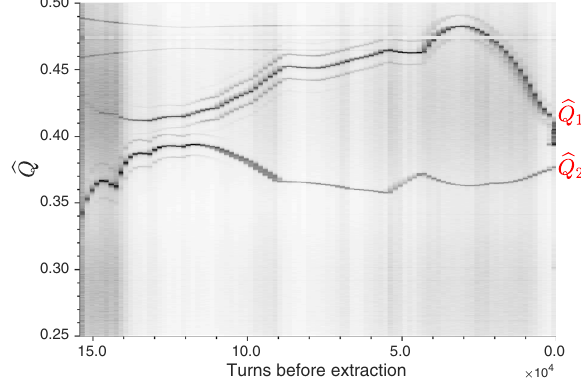
FIG. 13. Tune measurement along booster ramp with emittance exchange. The horizontal tune is brought close to the vertical one during the last ≈ 2500 turns. The beam is extracted shortly after the coupling resonance crossing to obtain the full emittance exchange.